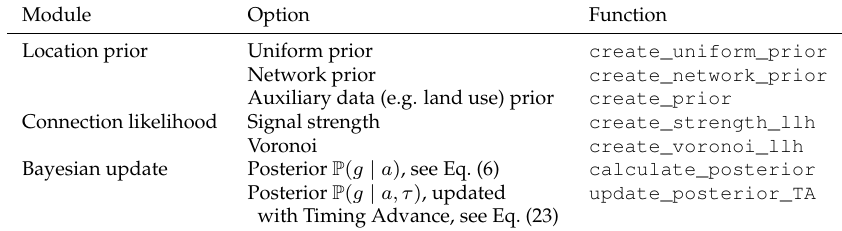
Table 3: An overview of mobloc